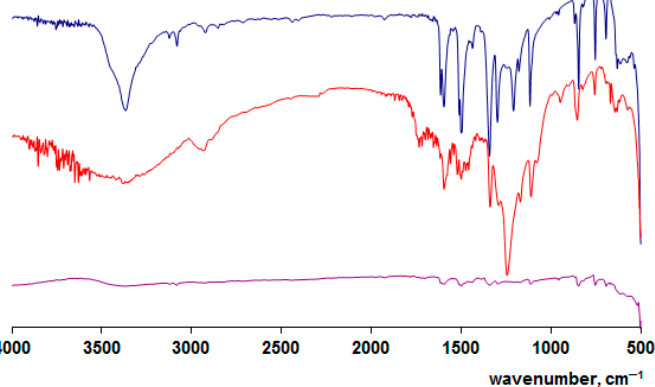
Figure 9. IR spectra of p-NP original solution (curve 1) and intermediate products of its decompo- sition under UV irradiation for 200 min (curve 2) and at visible light irradiation for 40 min (curve